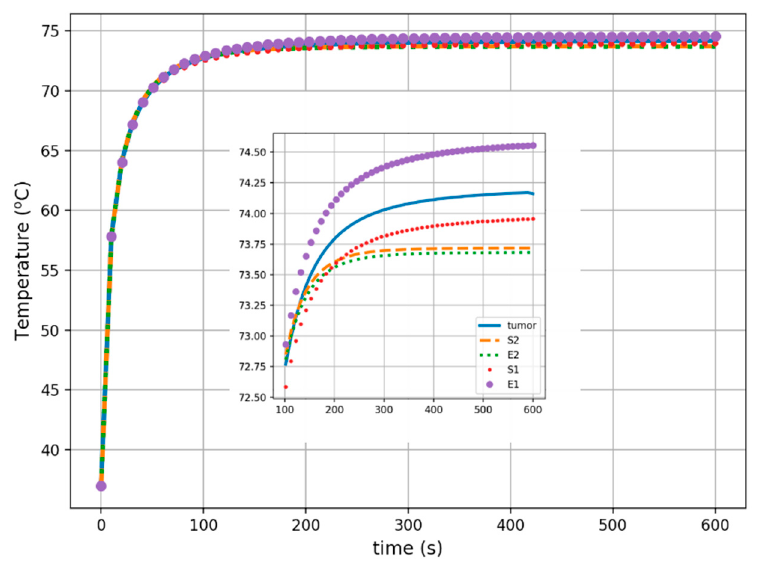
Figure 9. Time-dependent temperature distributions in the center of various tumors, including zoom view inside, where S 1 and S 2 correspond to spherical tumor models and E 1 and E 2 correspond to ellipsoidal tumor models.